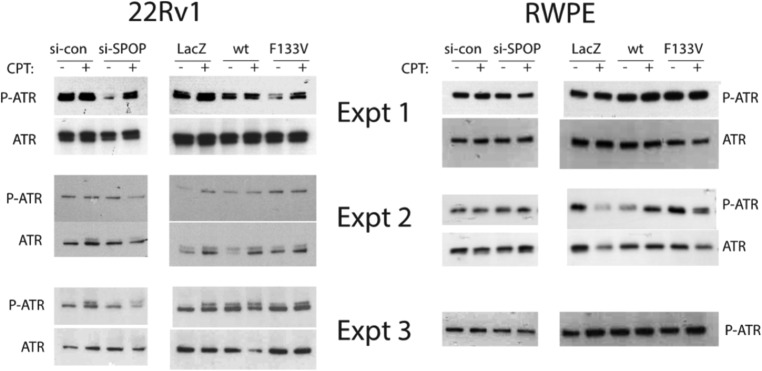
DOI:
http://dx.doi.org/10.7554/eLife.09207.027